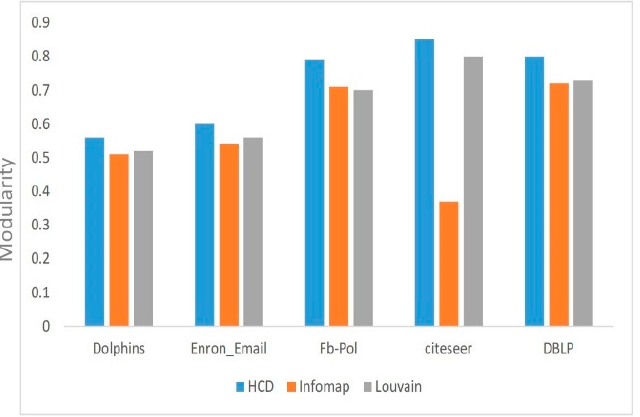
Figure 4. Results of modularity comparison of HCD algorithm with Infomap and Louvain algorithms.